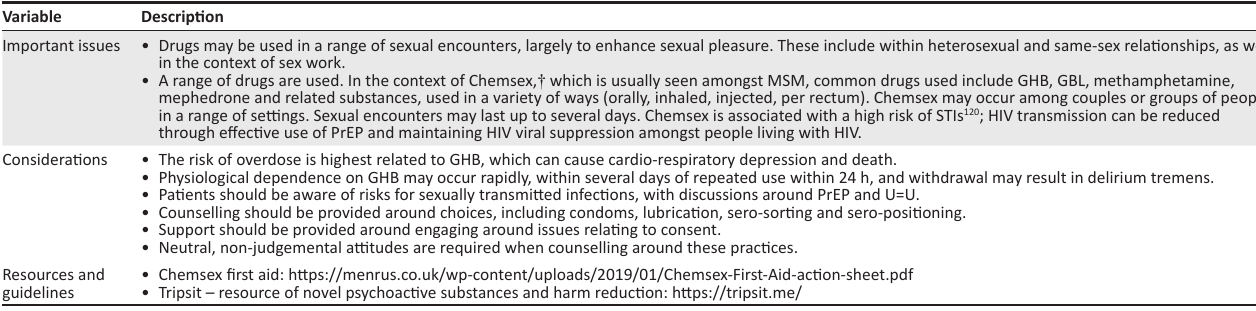
TABLE 27: Substance use in the context of sexual encounters. Variable